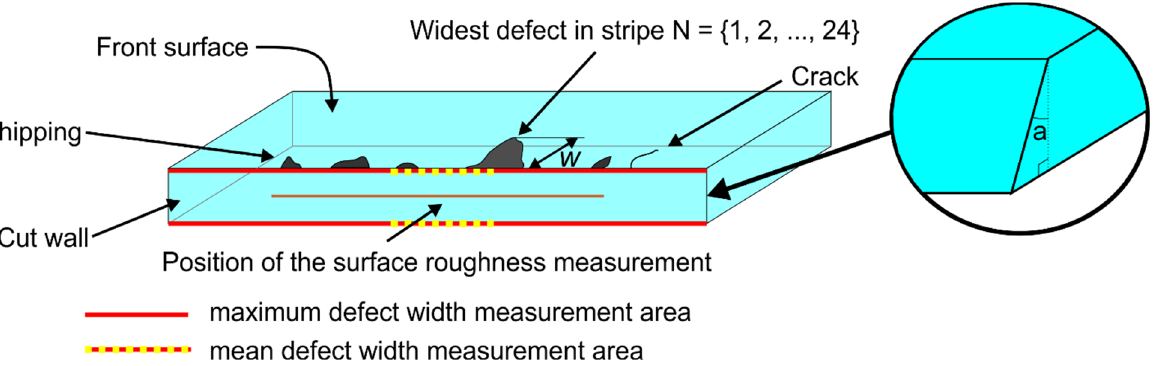
Figure 3. Schematic for evaluating the mean and maximum defect widths. Position for the cut-sidewall roughness measurements and cut-sidewall taper angle ( a ) are indicated.